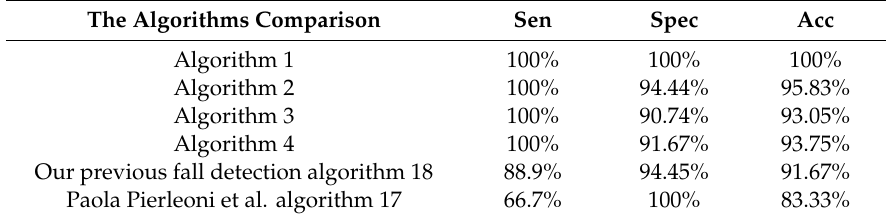
Table 7. The testing performance of our current proposed algorithms (fall detection and loss of physical performance detection), our previous fall detection algorithm, and Paola Pierleoni et al. algorithm on our experimental